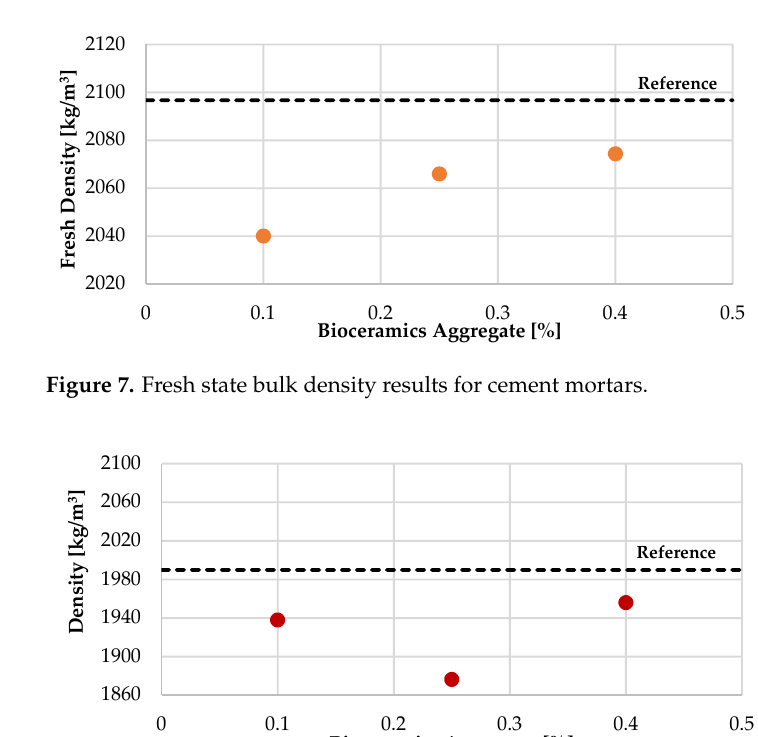
Figure 8. Dry state density results for cement mortars.